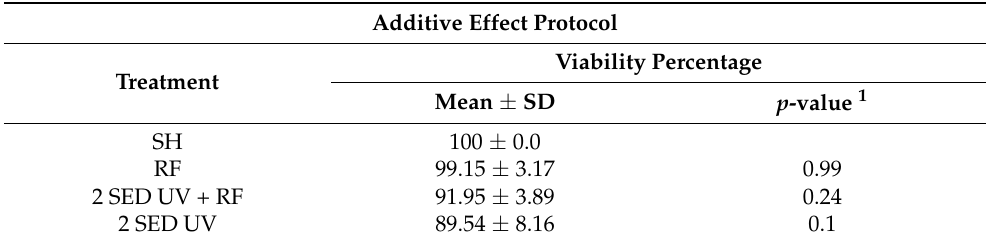
Table 1. Cell viability results under the additive effect protocol with 2 SED UV exposure followed by 24 h of 20 min on/off switch 4 W/kg SAR Wi-Fi